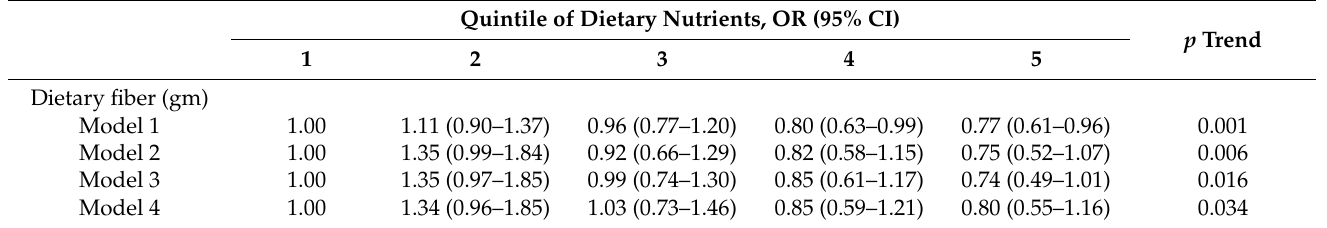
Table 3. Multiple logistic regression analysis of association of dietary nutrients with self-reported eye affliction/retinopathy in individuals with